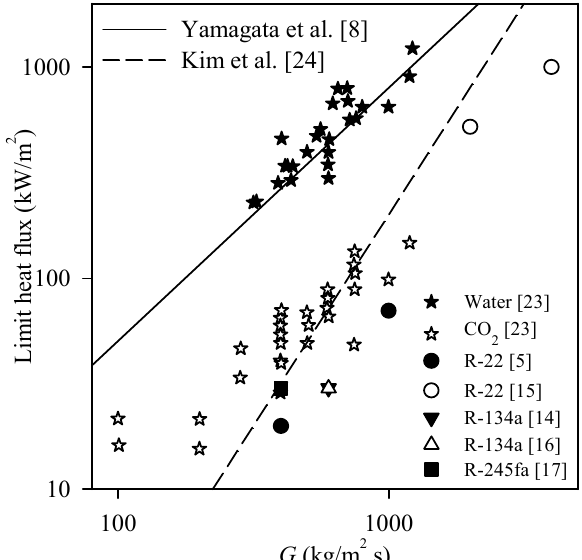
Figure 3. Comparisons of the limit heat flux (LHF) between correlations and experimental data against the mass flux for water, carbon dioxide and the organic fluids [5,14–17,23]. Table 2. The criteria and predicted the average deviation ( AD ) and standard deviation ( SD ) of the LHF of water and carbon dioxide